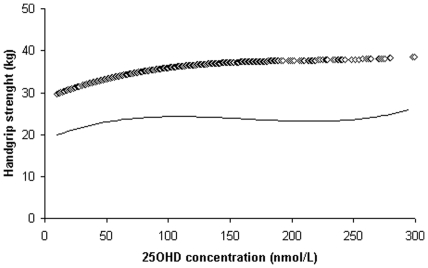
Loess regression plots of handgrip strength (kg) by 25-hydroxyvitamin D (25OHD) concentrations; straight line–for women and diamond line ◊◊ for men.